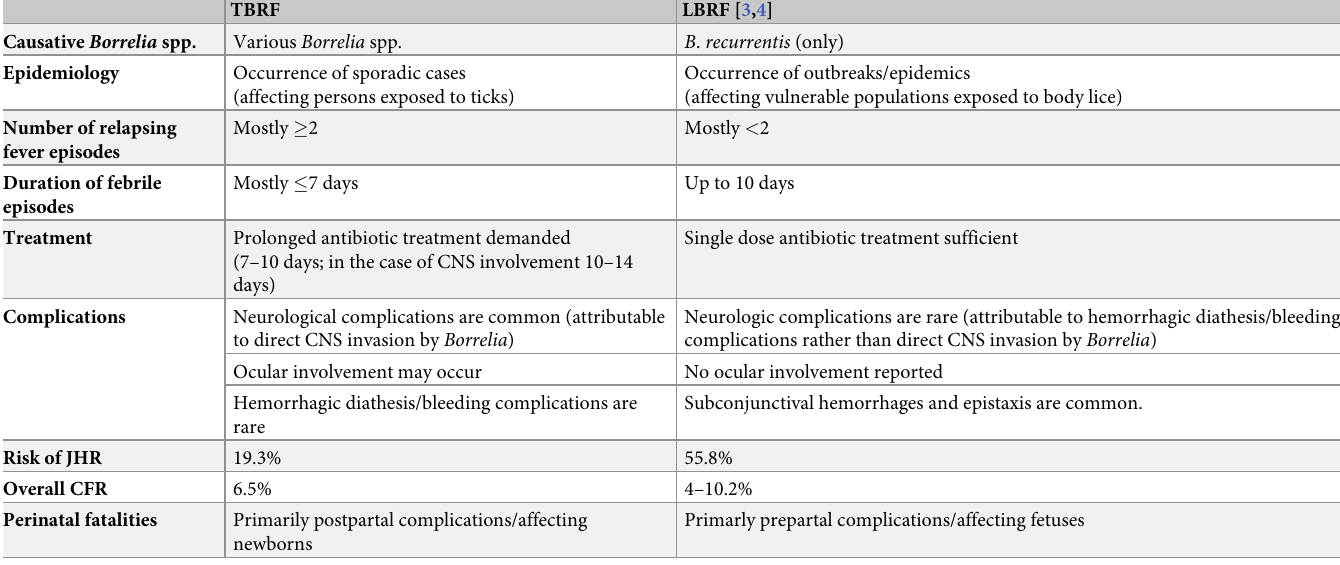
Table 9. Summary of characteristics of TBRF compared to